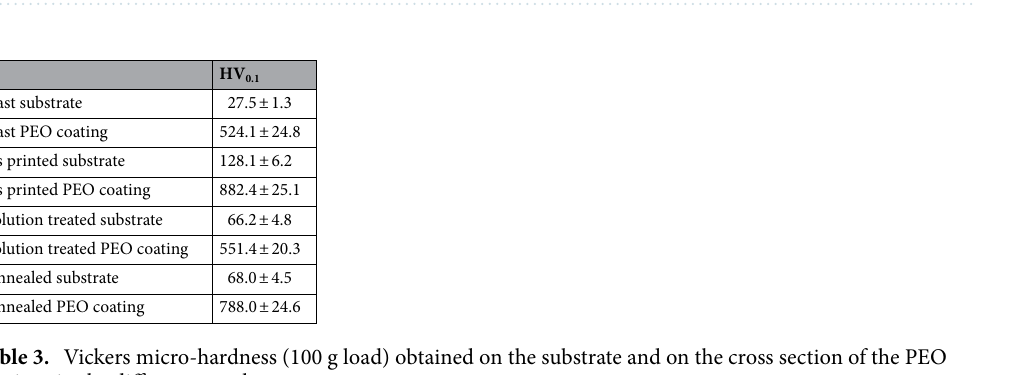
Figure 13. X-ray diffraction (XRD) pattern of PEO treated samples: cast sample ( a ); solution treated sample ( b ).